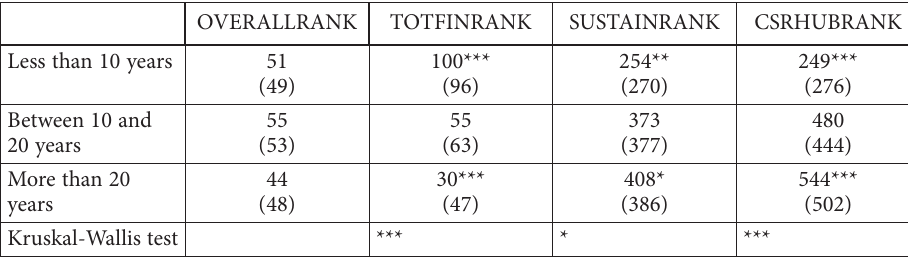
Table 7. Median (mean) positions in rankings by tenure 2